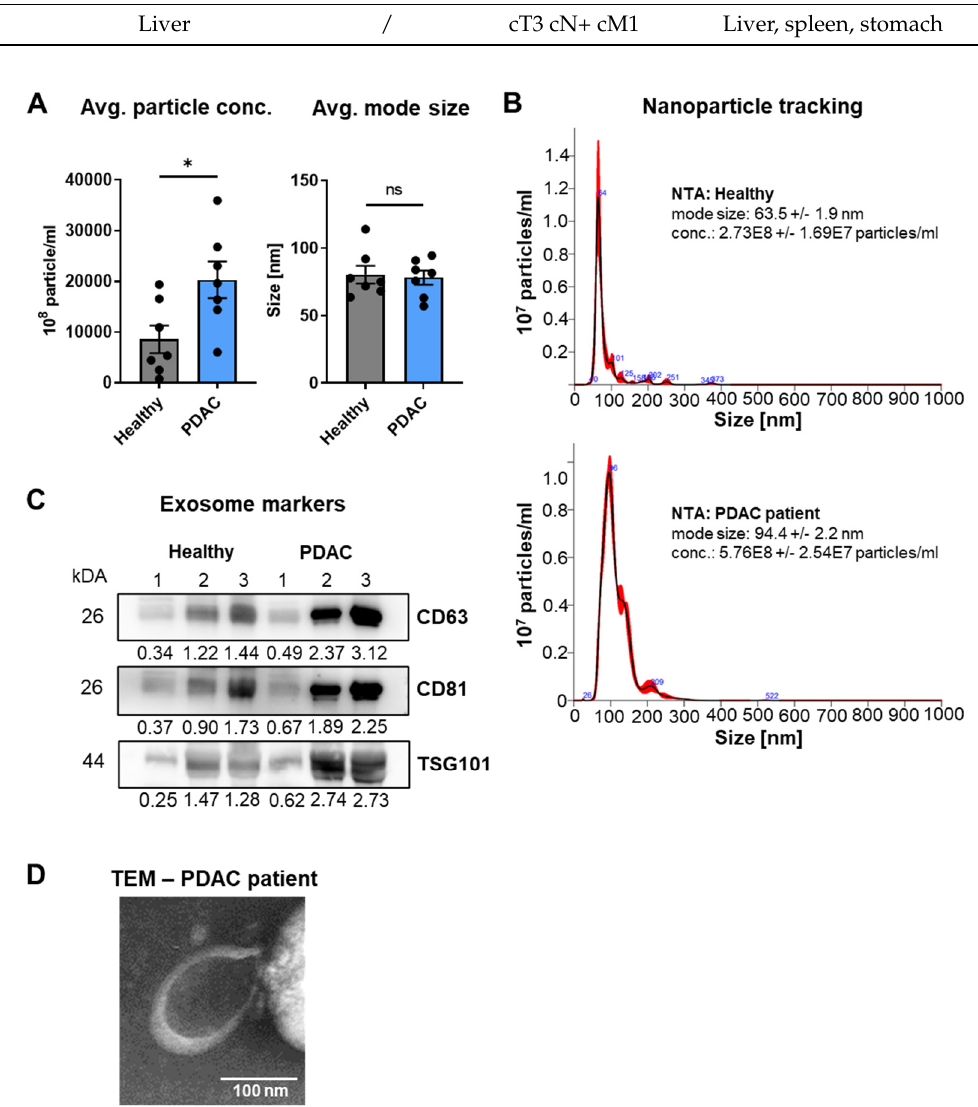
Figure 3. MISEV characterization of EVs after precipitation from plasma of exemplary PDAC patients ( n = 7) and healthy subjects ( n = 7). ( A ) Determination of EV particle concentration and mode size. ( B ) Exemplary NTA curves. ( C ) WB analysis of sEV markers for subjects (CD63, CD81, TSG101) and related densitometry of bands. The integrated density of WB bands was measured using ImageJ. To calculate the relative integrated density for each band, values were normalized on the mean of all three healthy subjects. ( D ) Exemplary TEM image of an EV isolated from PDAC patient plasma. Statistical tests: ( A ) Two-tailed unpaired Student t -test; * p < 0.05; ns: no significant differ- ence. In line with previous studies that demonstrated increased exosome secretion from tumor cells [30,31], PDAC patients (Table S3) showed a particle concentration significantly increased by 2.4-fold compared to healthy probands (Table S4). The presence of sEVs was further validated by the detection of exosome markers in Western blots (WBs), for three subjects each (Figure 3C). In line with particle tracking data, PDAC patients demonstrated increased levels of exosome surface markers CD63 and CD81 as well as increased levels for the luminal marker TSG101. The WB raw data are provided as Supplemental Figure S37. The presence of sEVs was further validated by transmission electron microscopy (TEM) of uranyl-shaded vesicle preparations with typical cup-shaped features (Figure 3D). 3.2. evDNA Contains Significantly More Longer DNA Fragments Compared to cfDNA